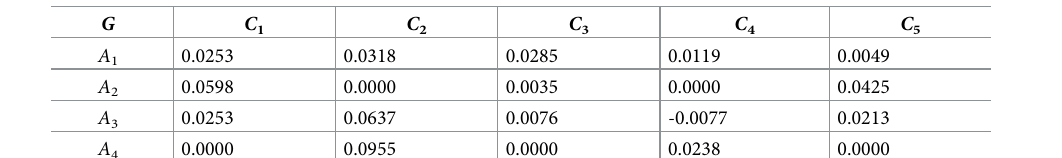
Table 6. Difference matrix G